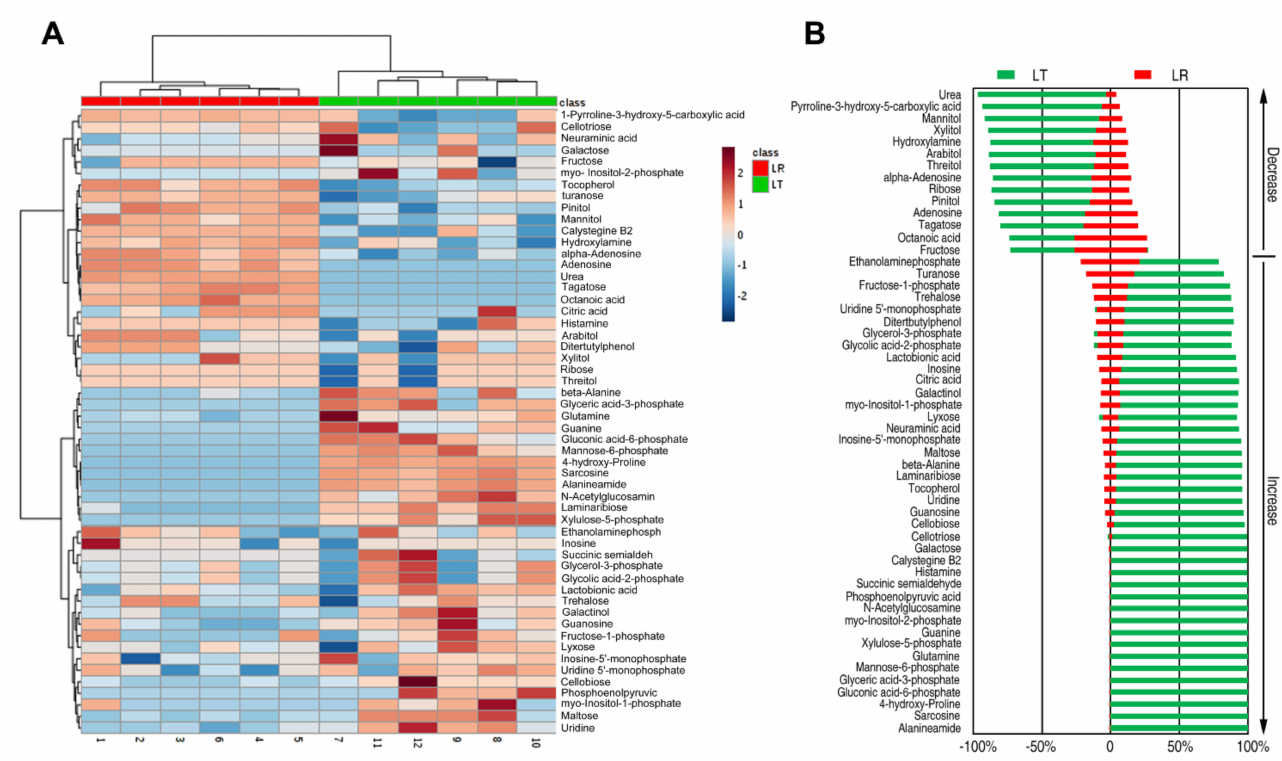
Figure 2. Varied metabolomes in 35 d embryos between LT and LR. ( A ) Heat map showing the relative abundance of significantly varied metabolites in LT and LR as indicated, respectively. ( B ) Z -values (standard deviation from average) of the LT group correspond to data in significant metabolites. Z -value based on the LR was calculated to identify the differential abundance of metabolites of LT compared to